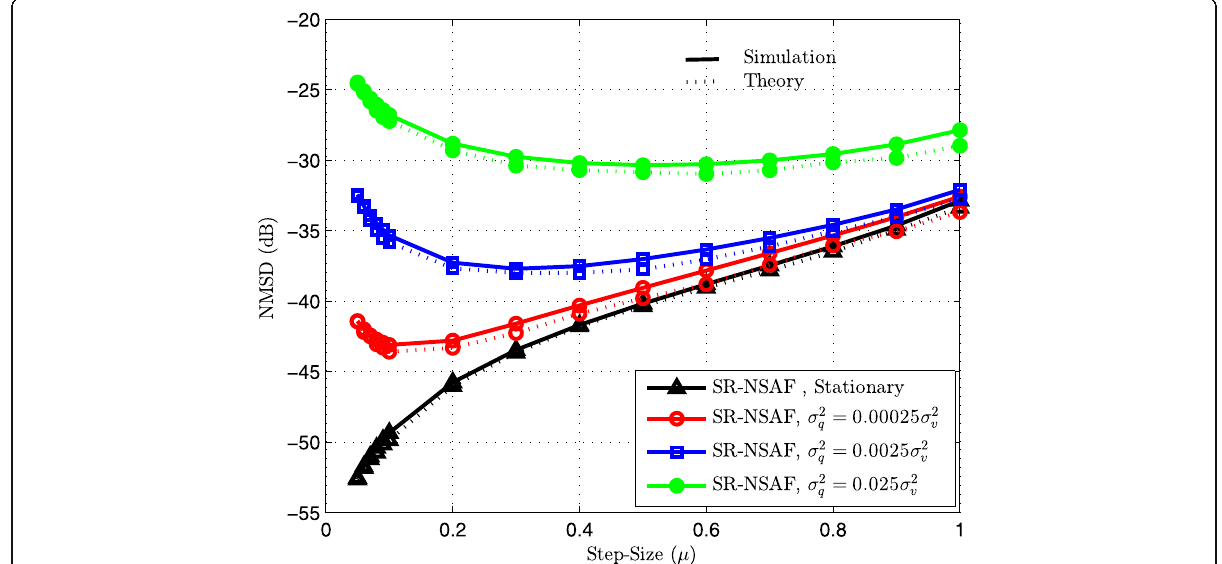
Fig. 29 Simulated and theoretical steady-state NMSD of SR-NSAF as a function of the step-size in nonstationary environment for different values of σ 2